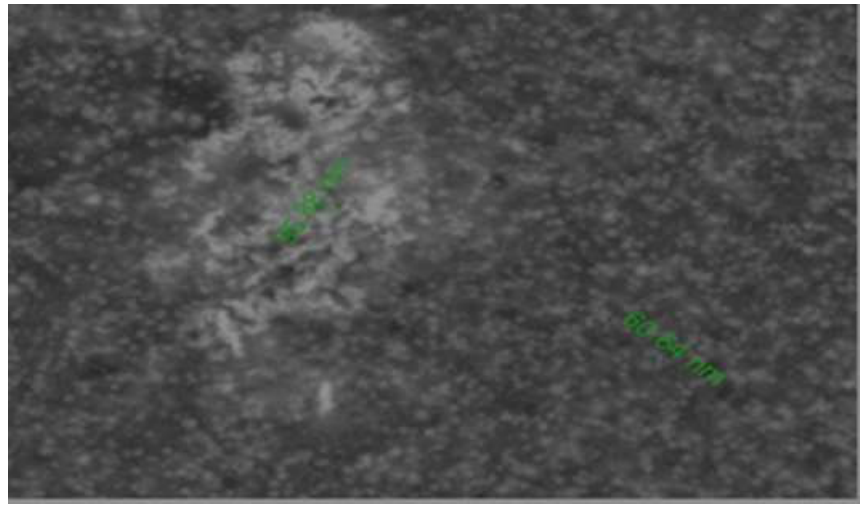
Figure 3. Characterization of nanoparticles’ using